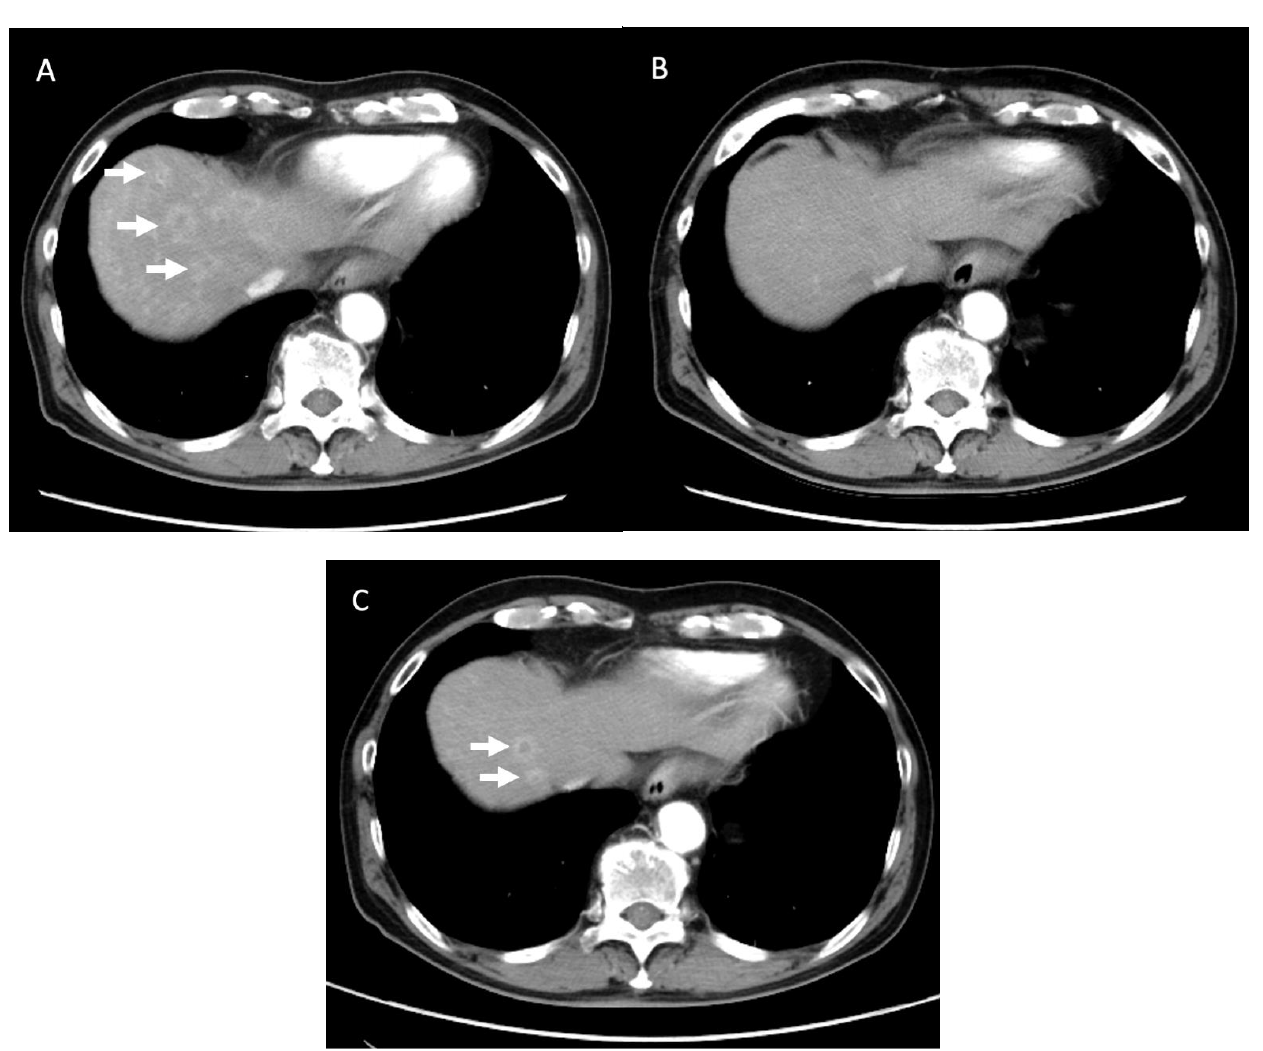
Figure 5. Computed tomography (CT) findings of Patient #1. ( A ): CT showed multiple metastatic lesions (white arrow) in the liver before chemotherapy. ( B ): All liver metastasis disappeared on CT after chemotherapy. ( C ): Cancer recurrence in the liver (white arrow) was confirmed 8.5 months after conversion